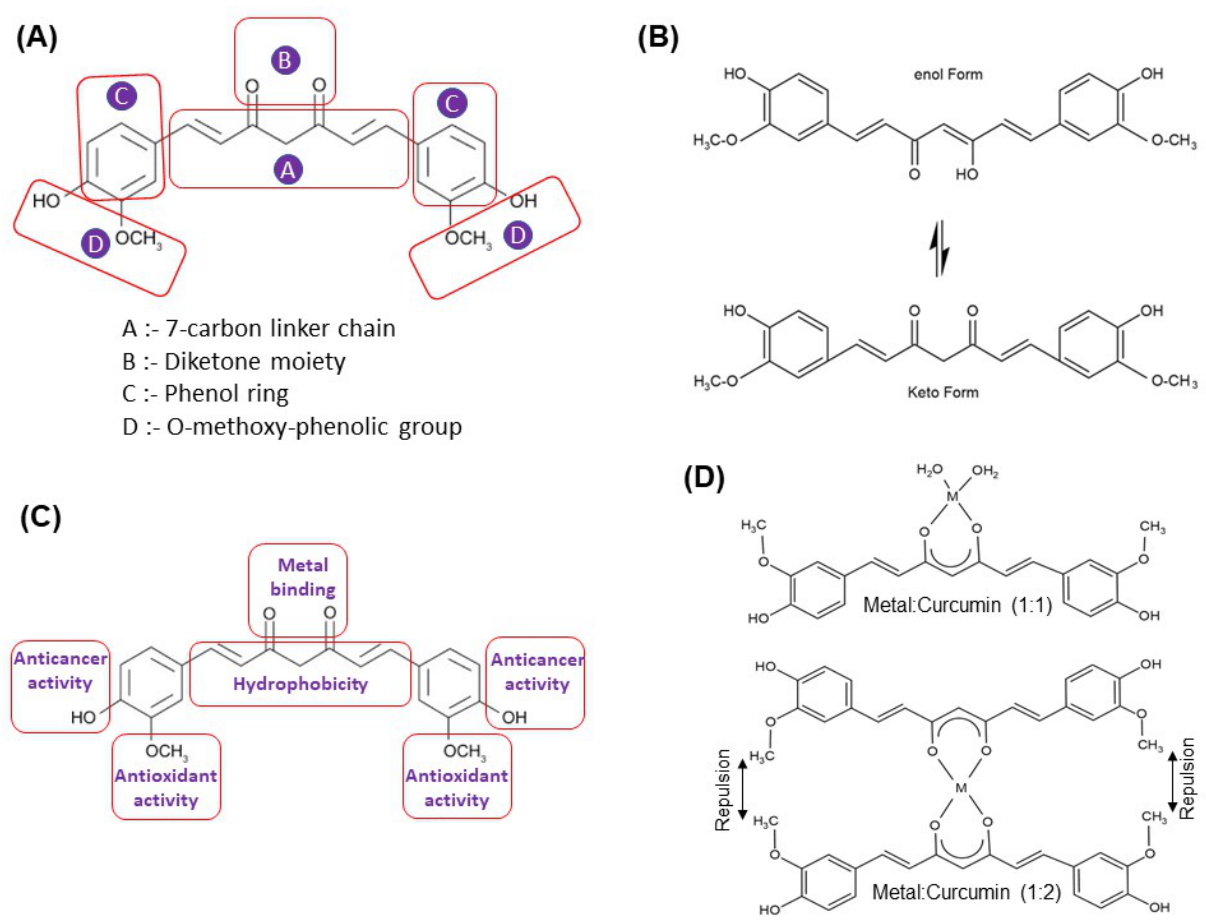
Figure 1. ( A ) The basic structure of curcumin. ( B ) Existence of curcumin in keto-enol tautomeric forms. ( C ) Groups of curcumin responsible for its biological properties. ( D ) Structure of 1:1 and 1:2 metal:curcumin complexes showing the β -diketone moiety of curcumin as the metal binding